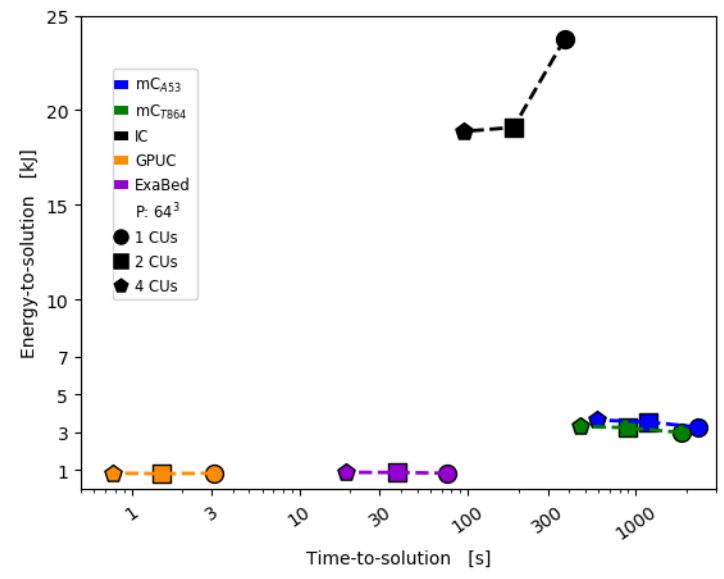
Figure 3. The performance-consumption plane for 64 3 particles varying the number of CUs